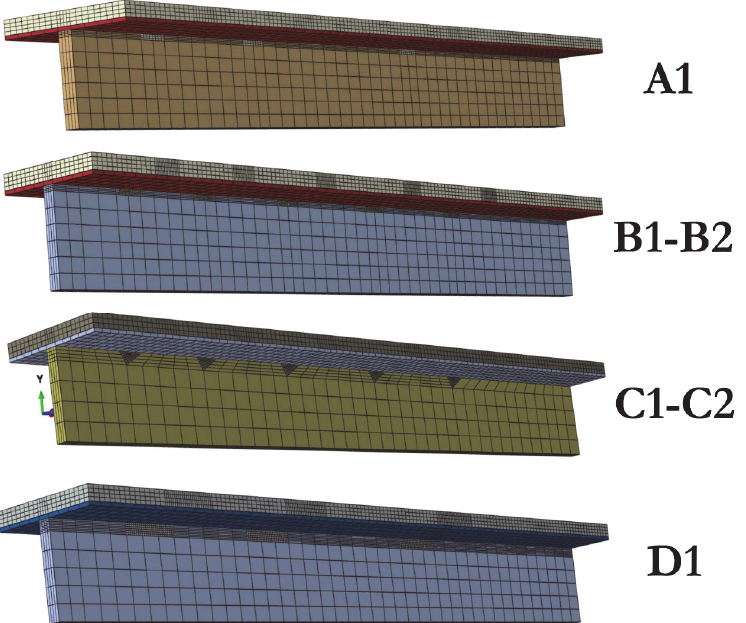
Figure 6: mesh of the simulated TCC beams with reduction section: A1, B1, B2, C1 and